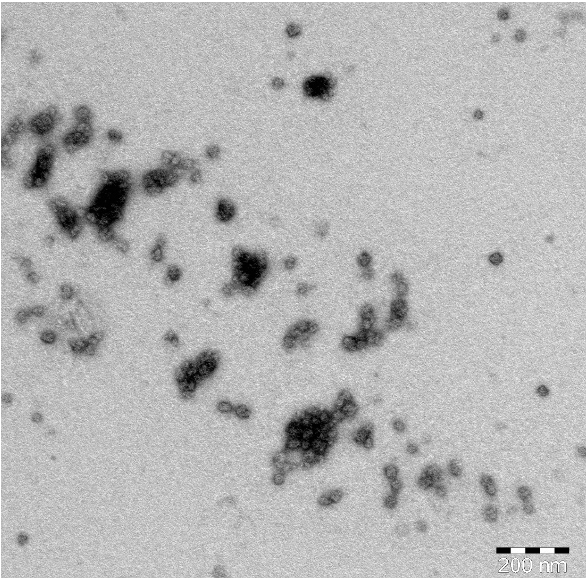
Figure 5. TEM image of the optimized SIT-GA nano-conjugates.